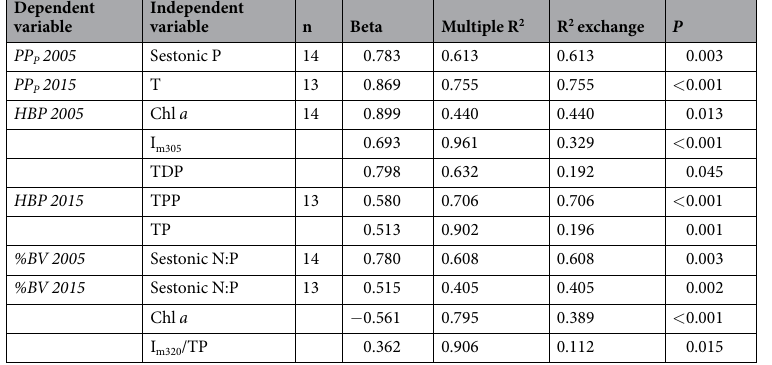
Table 2. Multiple stepwise regression for primary production (PP P ), bacterivory (%BV) and bacterial production (HBP) in 2005 and 2015 (independent variables included in the table are only those which are statistically